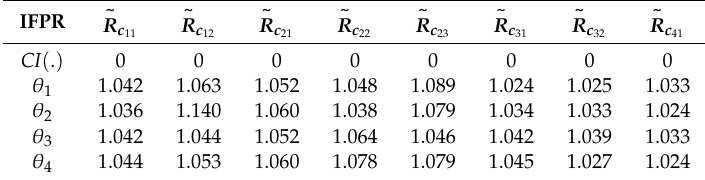
Table 6. Consistency indices and θ i values ( i = 1,2,3,4 ) of the generated IFPRs.